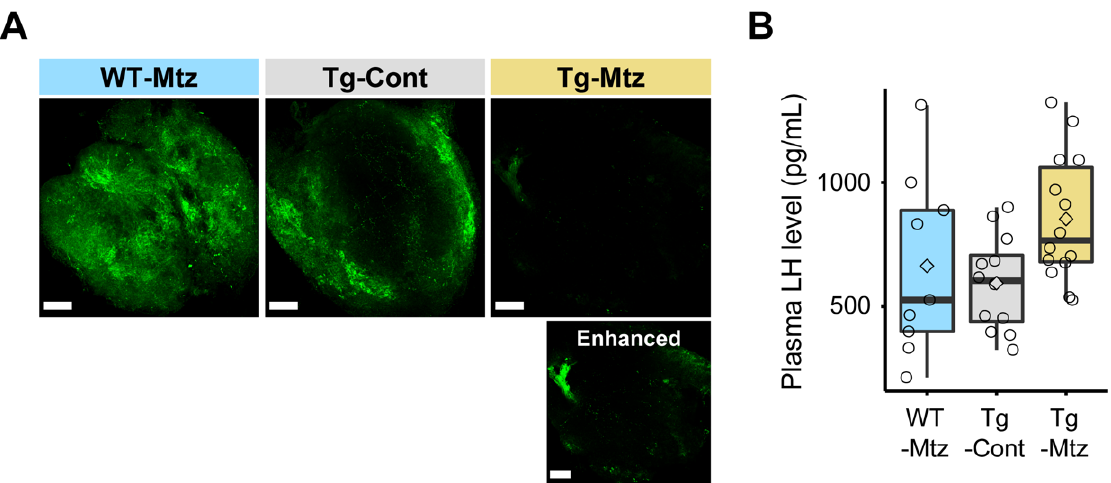
Figure 2. GnRH3 neuronal projections are reduced at 28 days of treatment in the pituitary of GnRH3 neuron-ablated females. ( A ) Confocal images of immunostaining with GnRH3-associated peptide antibody in the whole pituitary (posterior to top left ), showing GnRH3 neuronal projections (green). Scale bars, 1 mm. The bottom panel of Tg-Mtz, an image with enhanced signals with levels and tone curve adjustments to demonstrate that GnRH3 is still detectable in the pituitary. ( B ) LH levels in plasma ( n = 9–14). WT-Mtz, WT siblings treated with 2 mM metronidazole (Mtz); Tg-Cont, Tg(gnrh3:Gal4ff; UAS:nfsb-mCherry) treated with vehicle; Tg-Mtz, Tg(gnrh3:Gal4ff; UAS:nfsb ‐